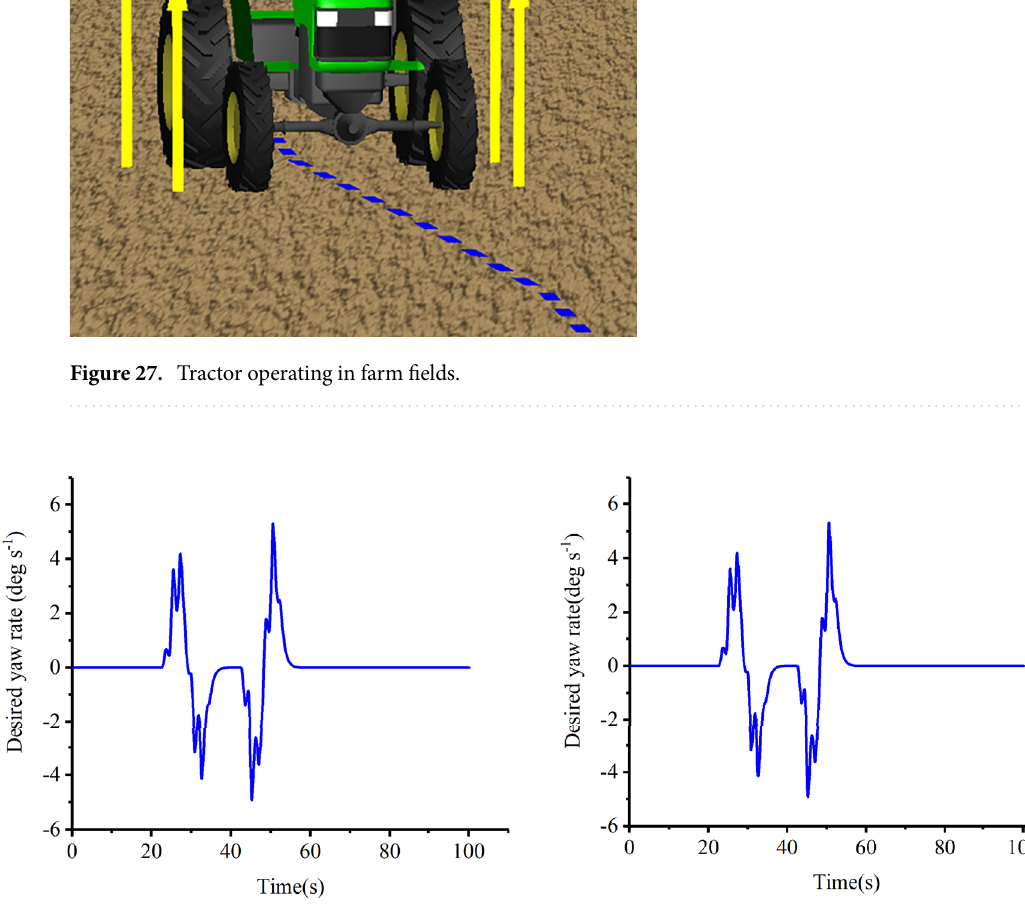
Figure 28. Effect of the road friction coefficient on the desired yaw